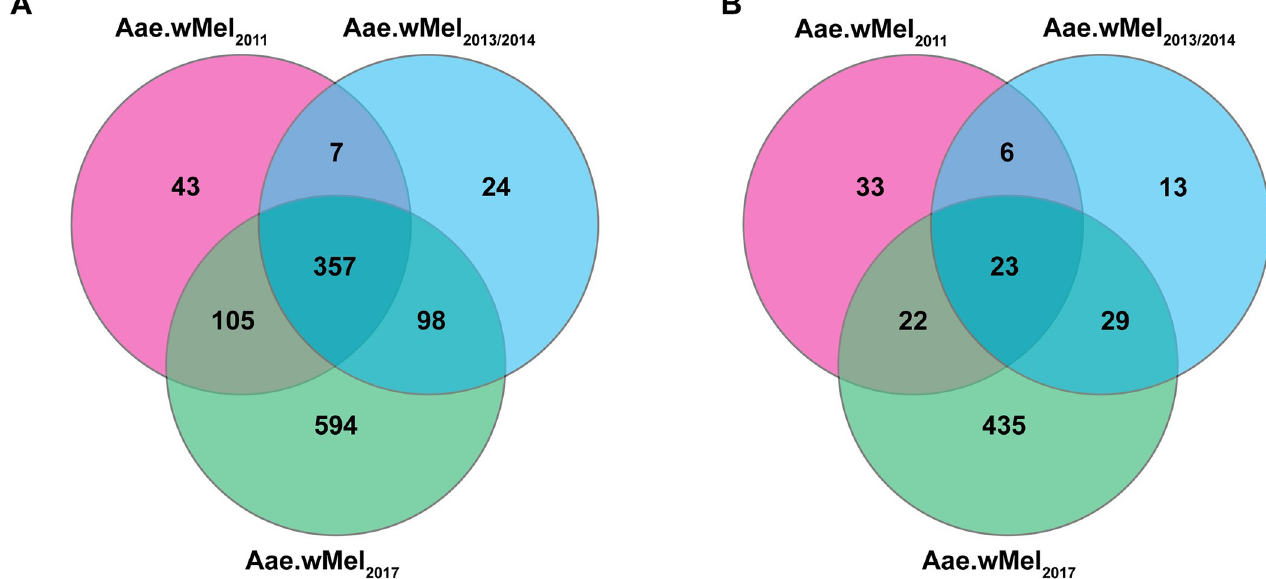
Fig 4. Numbers of shared and uniquely (A) upregulated and (B) downregulated genes in mosquitoes from populations with different w Mel release histories.